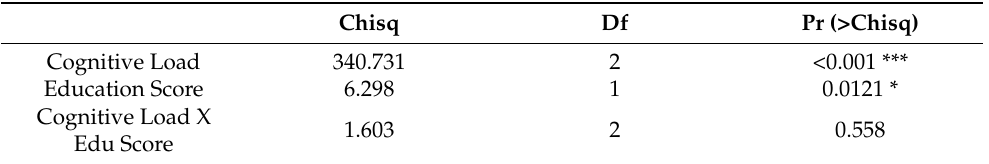
Table 6. Analysis of deviance with the type II Wald chi-square tests for memory score as a function of Cognitive Load and Education score. (*,*** = p -value < 0.05 and 0.001 respectively). Chisq Df Pr (>Chisq) Cognitive Load